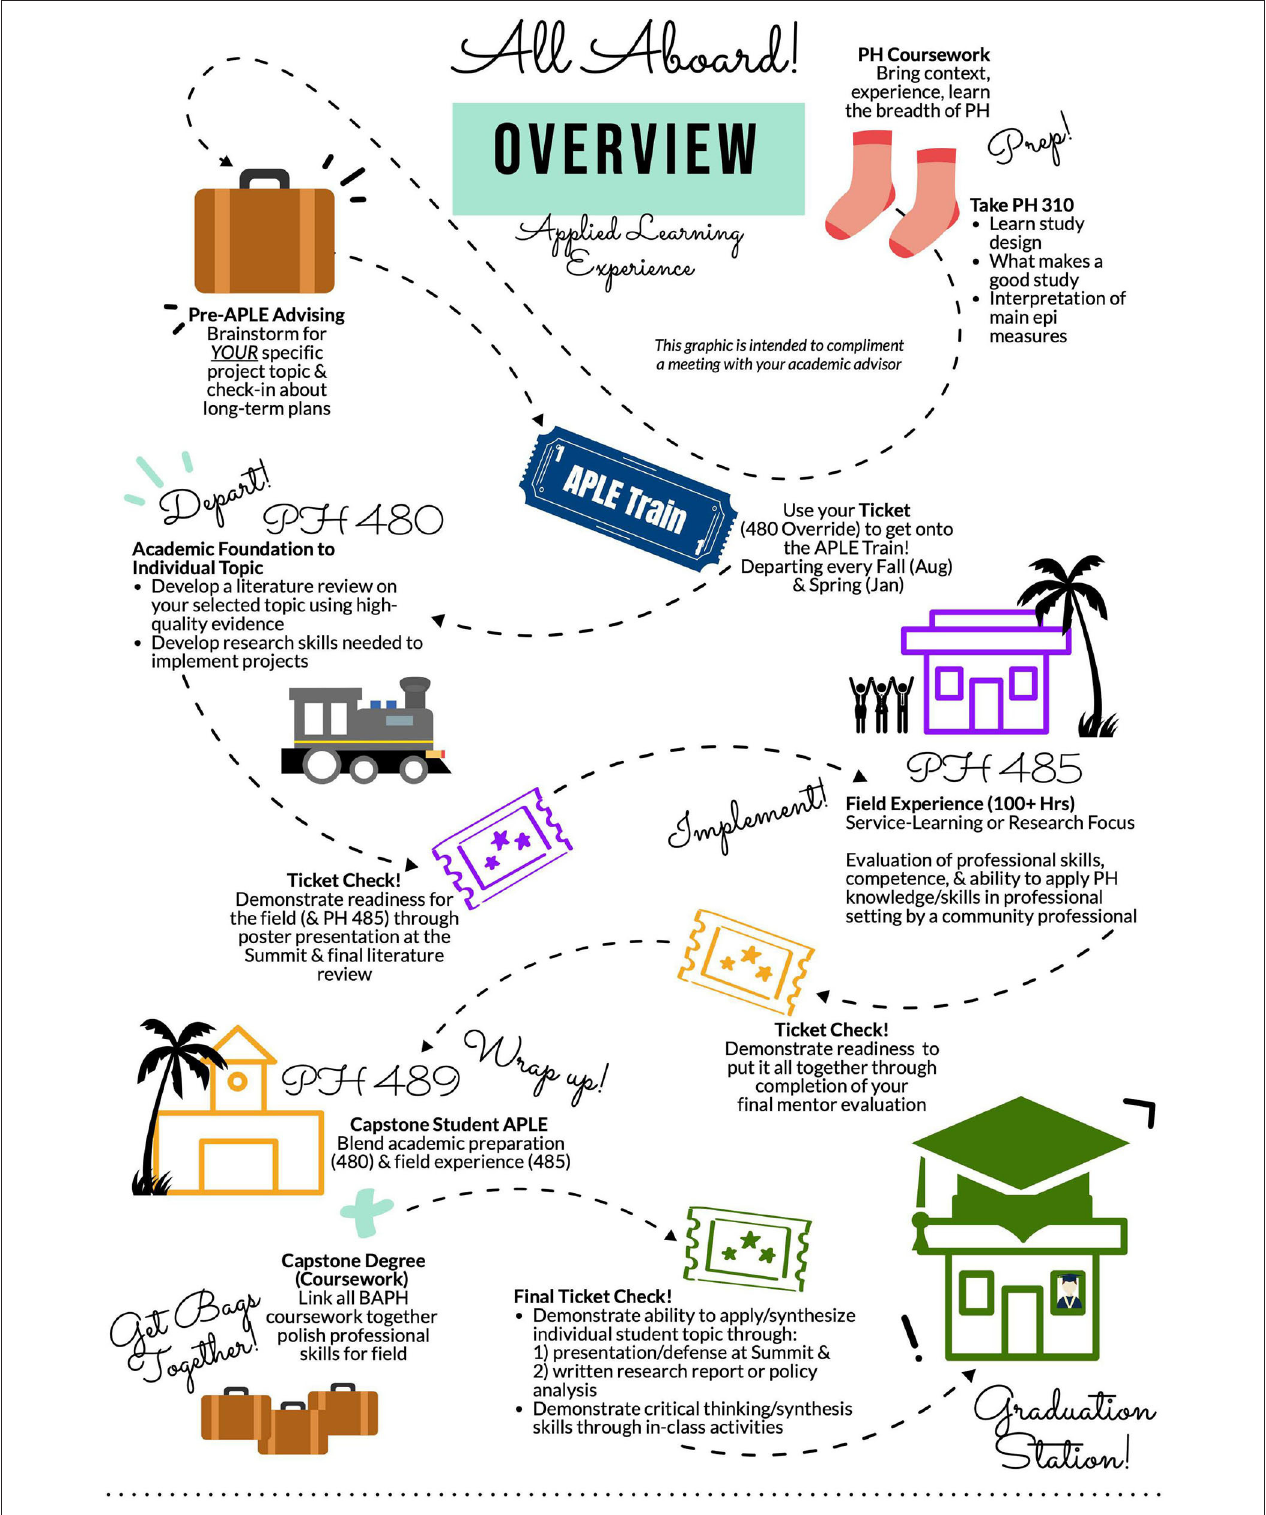
FIGURE 1 | Visual curriculum map for three-course capstone experience applying train analogy.